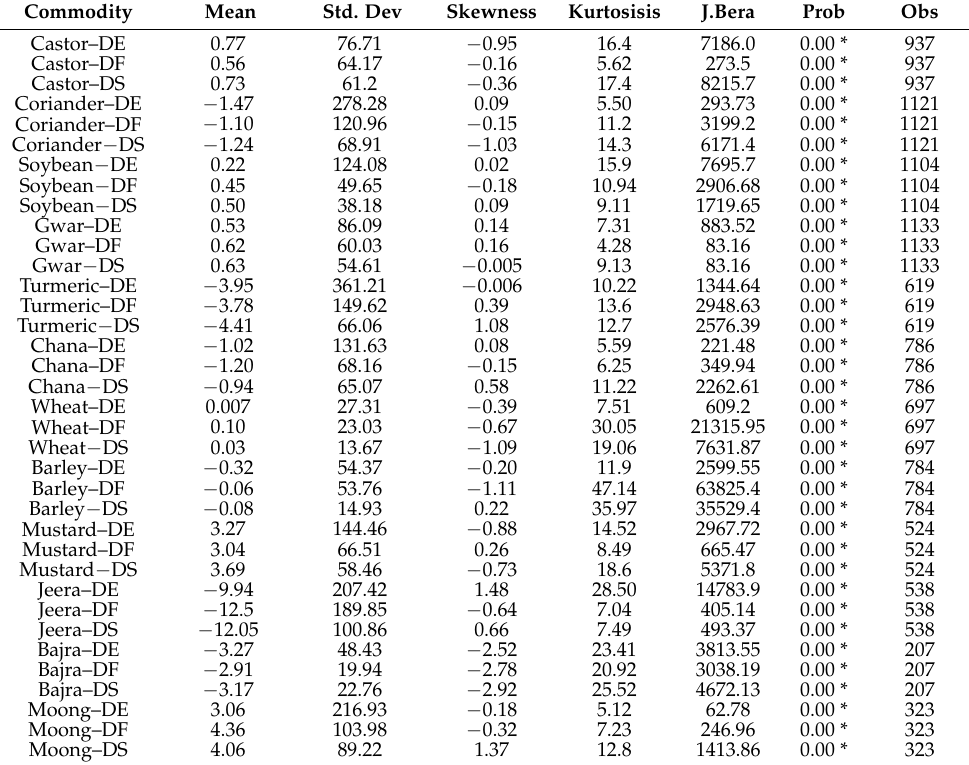
Table A2. Descriptive statistics for differenced